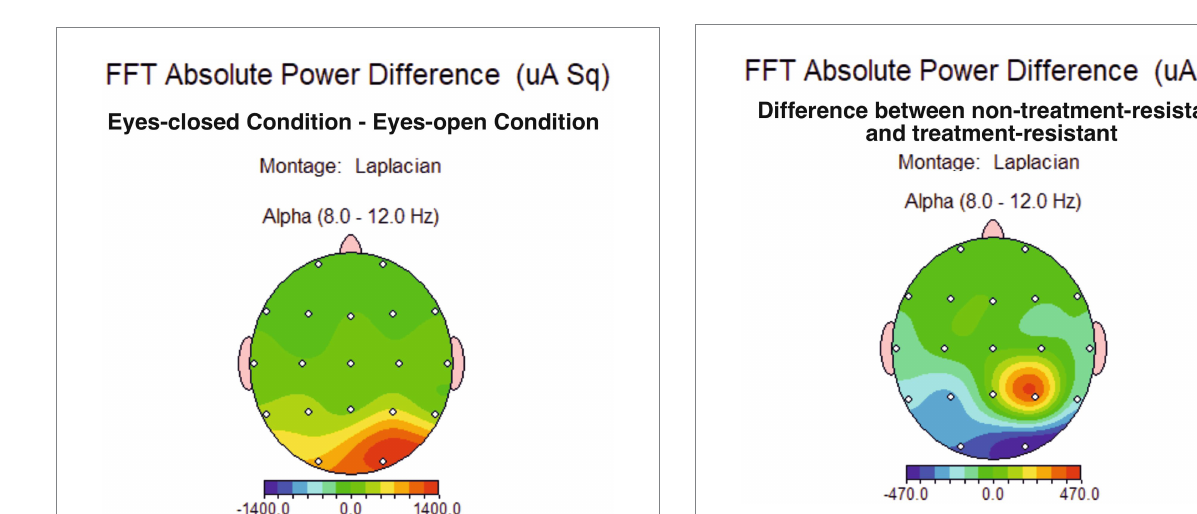
Depression diagnosis depending on alpha asymmetry location Alpha asymmetry was not significantly different for participants diagnosed with treatment-resistant depressive disorder, compared to those that did not have this diagnosis, F (1, 22) = 0.12, p = 0.735,